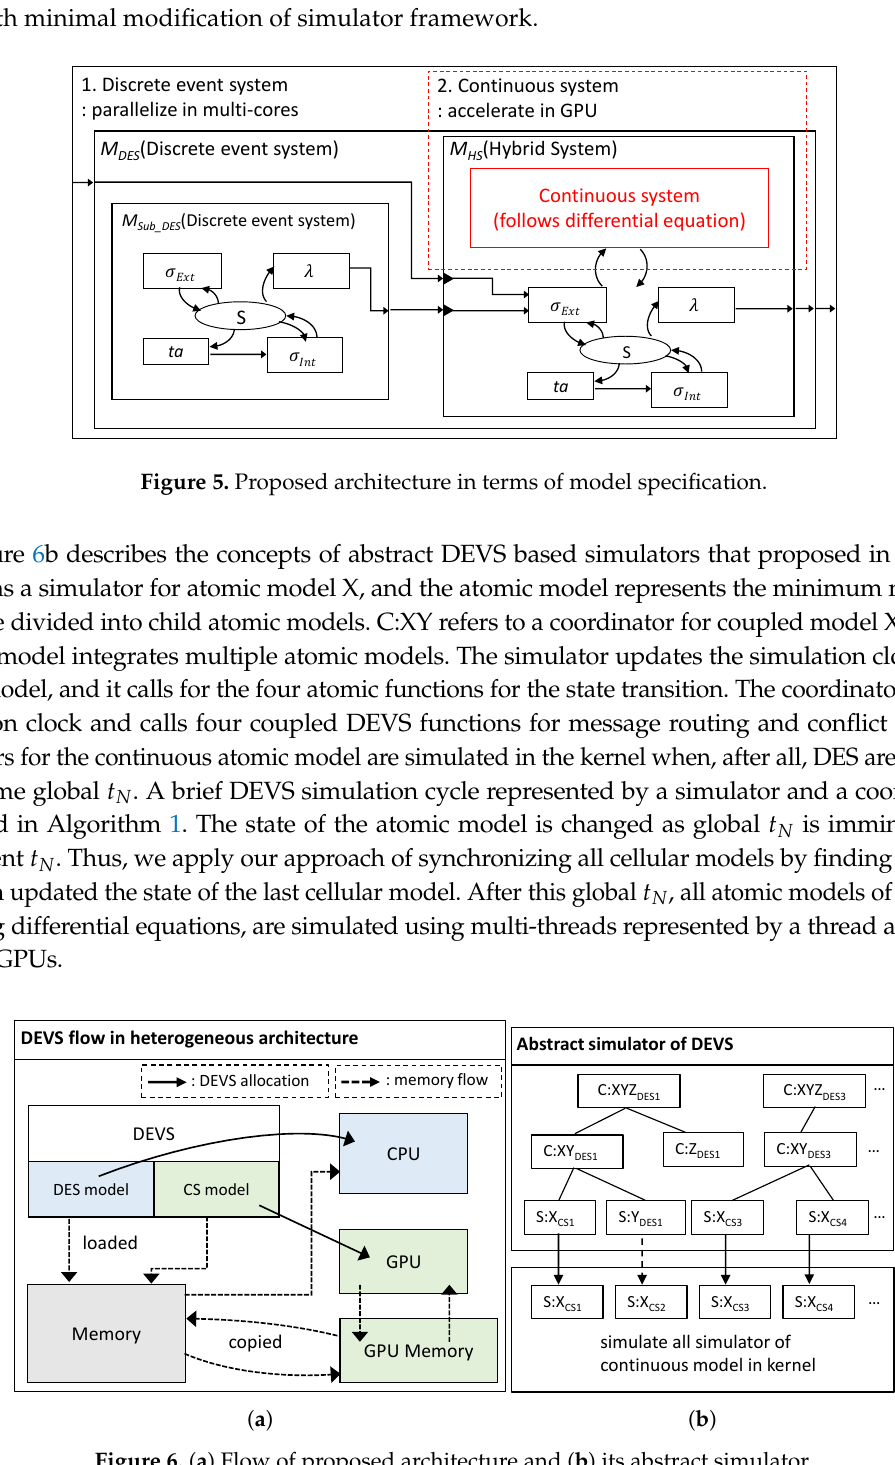
Figure 6. ( a ) Flow of proposed architecture and ( b ) its abstract